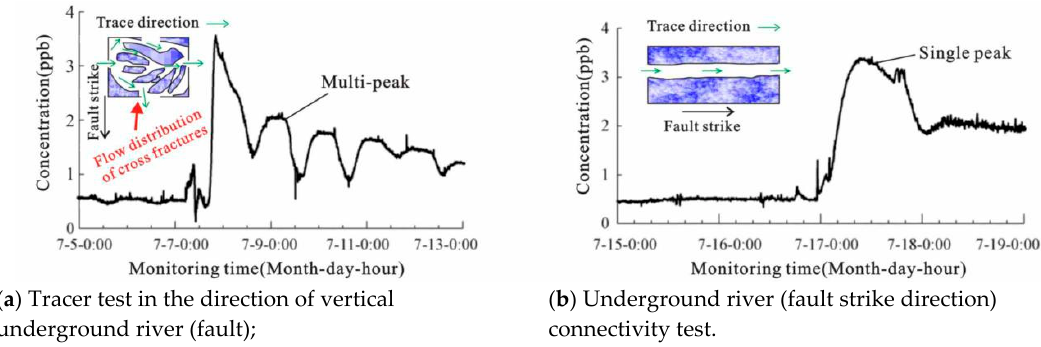
Figure 10. Characteristics of the peak curve of the tracer test in the tunnel area. Image recreated from [29].